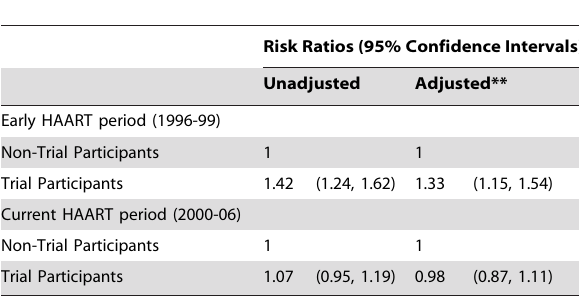
Table 3. Risk Ratios for virologic suppression by trial participation within strata of HAART